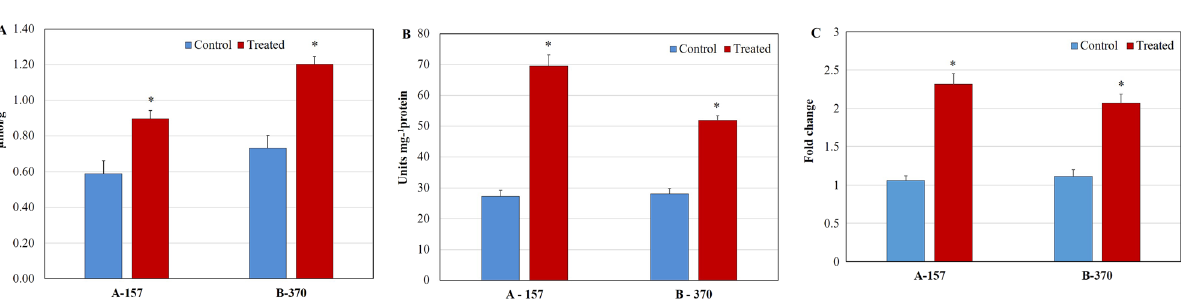
Figure 3. Estimation of ( A ) Ornithine content ( B ) OAT enzyme assay ( C ) OAT gene expression in leaf tissue of aromatic rice cultivars grown under salt